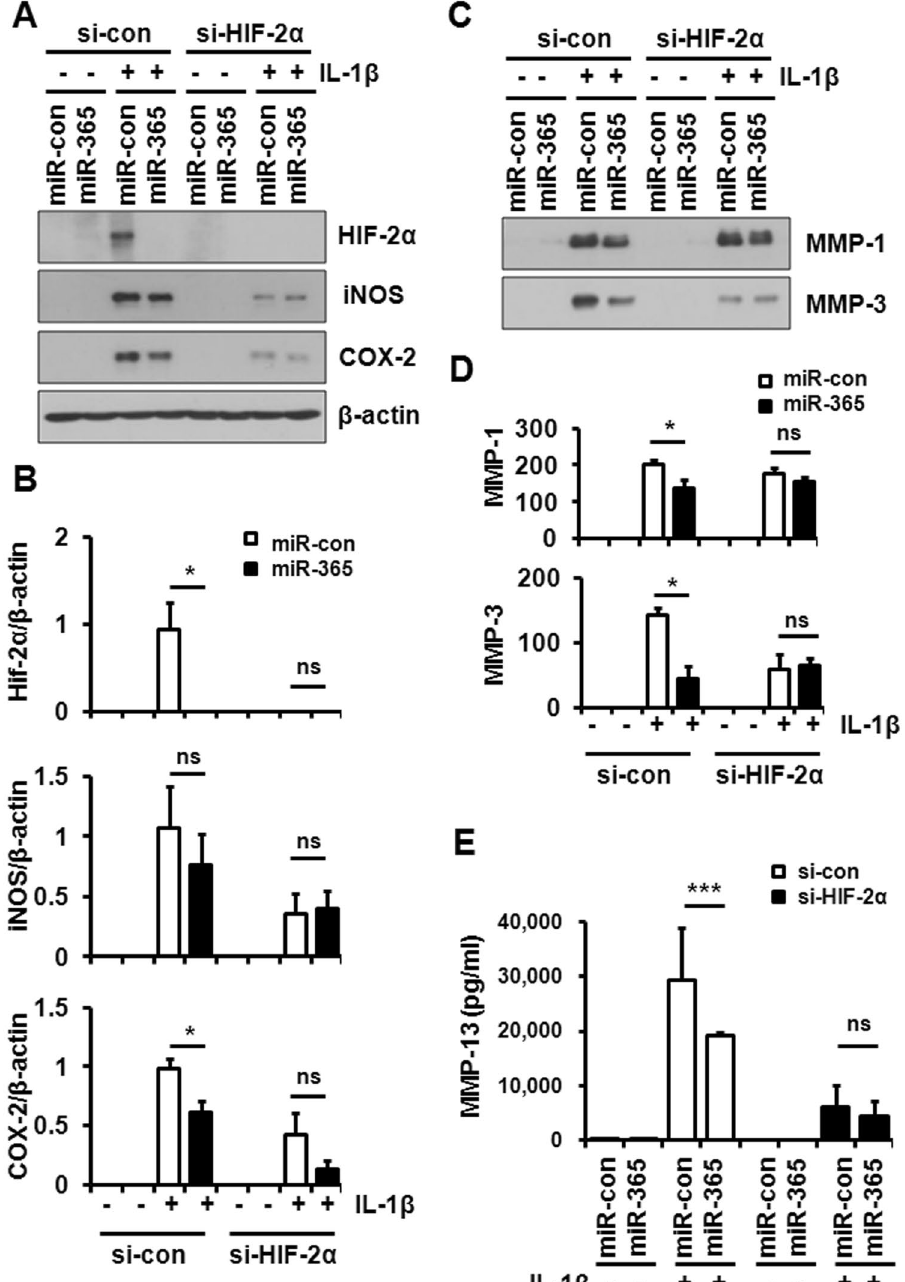
Figure 6. Suppression of IL-1 β -mediated catabolic effect by miR-365. Human OA chondrocytes were transfected with miR-365 or miR-con and si-con or si-HIF-2 α for 48 h and stimulated with IL-1 β (1 ng/mL) for 24 h. ( A ) Expression of HIF-2 α , inducible nitric oxide synthase (iNOS), and cyclooxygenase-2 (COX-2) in cell lysates and ( C ) matrix metalloproteinases (MMP-1 and -3) in the culture medium were analyzed by Western blot. Beta-actin ( β -actin) was used as a loading control. The immunoblots shown are representative of three or more independent experiments. ( B ) The expression levels of HIF-2 α , iNOS, and COX-2, and ( D ) the level of MMP-1 and -3. ( B ) Protein density was normalized to β -actin. Data are expressed as the mean ± SD of more than three independent experiments. ns, not significant, * P < 0.05 vs. miR-con-transfected cells. ( E ) MMP-13 levels in the culture medium were measured by enzyme-linked immunosorbent assay (ELISA). Data are expressed as the mean ± SD of duplicate data from more than three independent experiments. ns, not significant, * P < 0.05 vs. miR-con treated